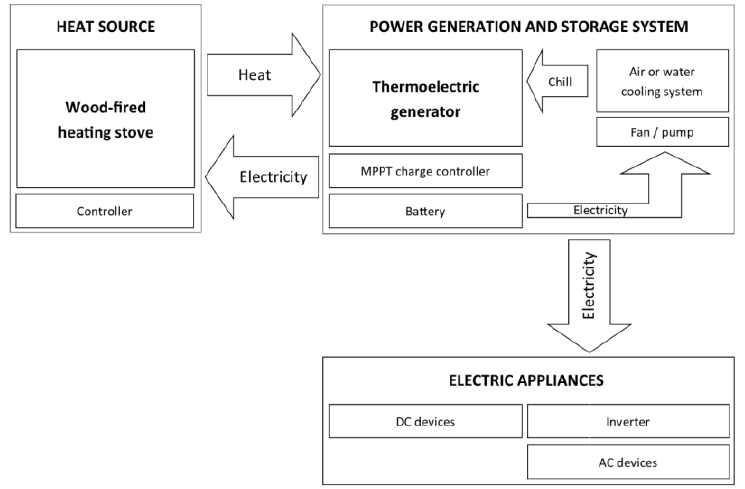
Figure 2. The idea of an mCHP system with a wood-fired heating stove and a